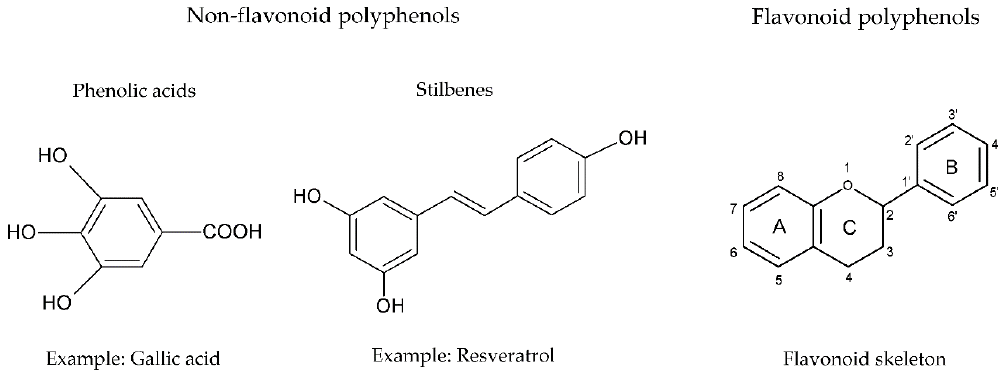
Figure 1. Flavonoid and non-flavonoid polyphenolic compounds. Adapted from References [20,21].